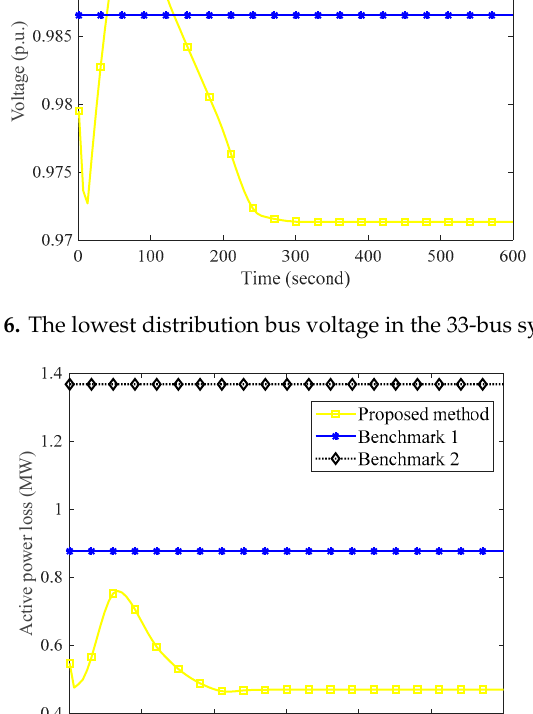
Figure 7. The total active loss of all 33-bus systems.